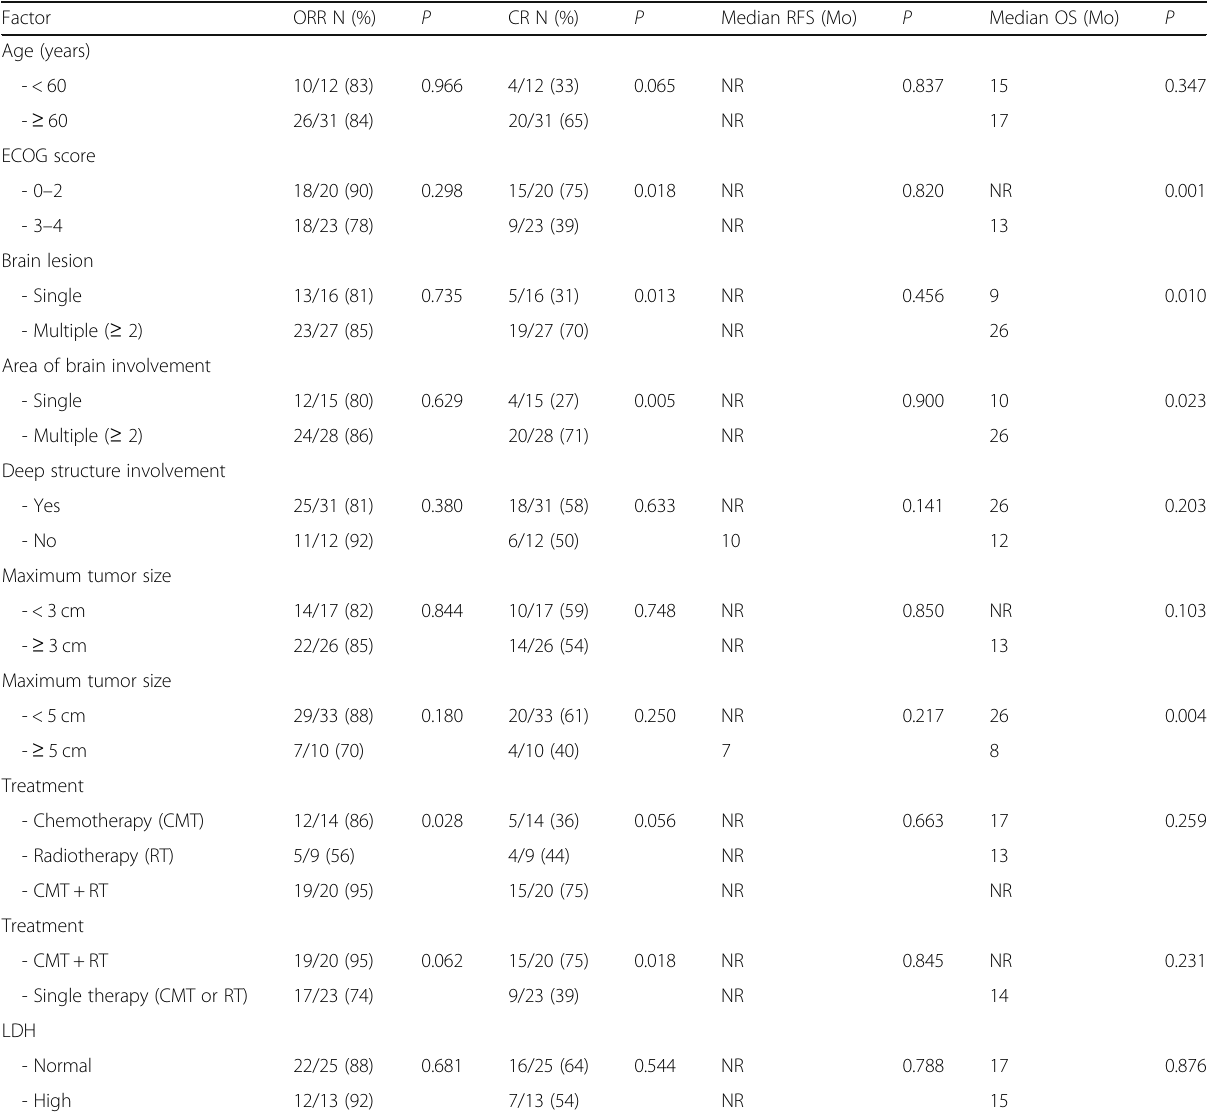
Table 1 Patients ’ characteristics and treatment outcomes in 43 adult patients with PCNSL